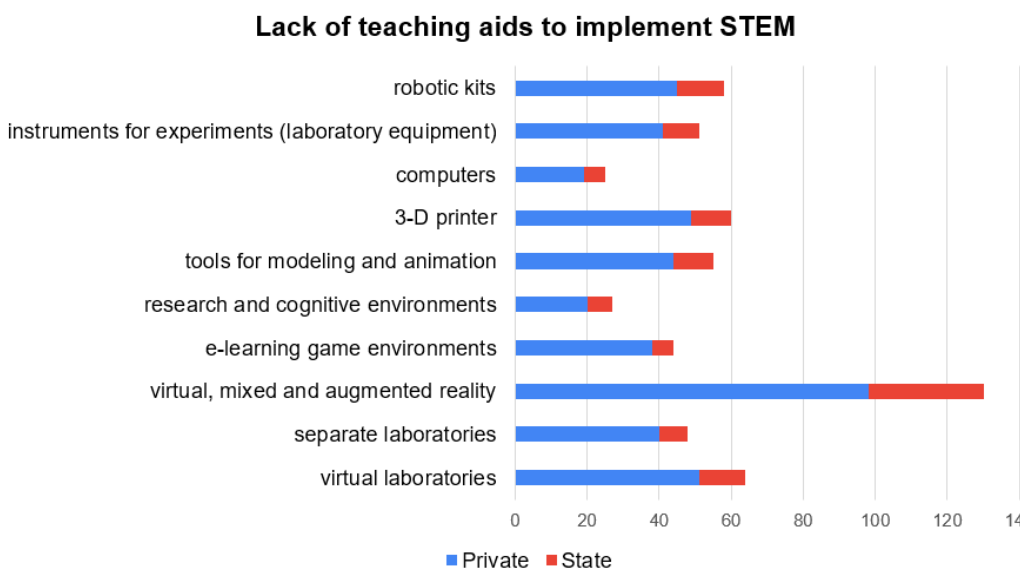
Figure 9: The result of a survey on the use of teaching aids in conducting STEM